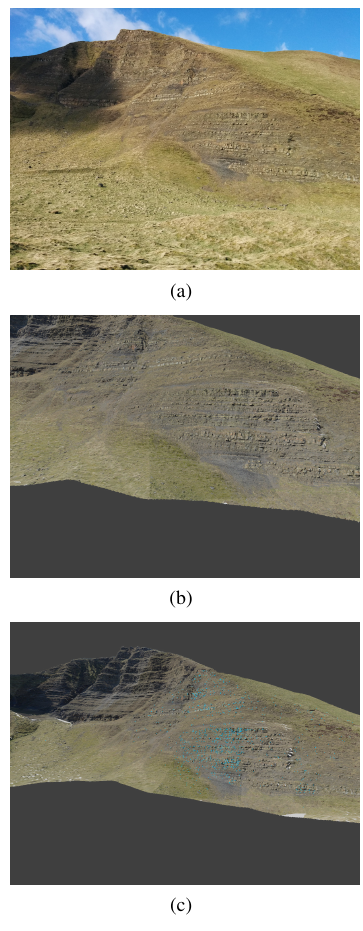
Figure 4: Comparative image series between a captured photo (a) and its corresponding synthetic images using the initial pose (b) and the final pose (c) after